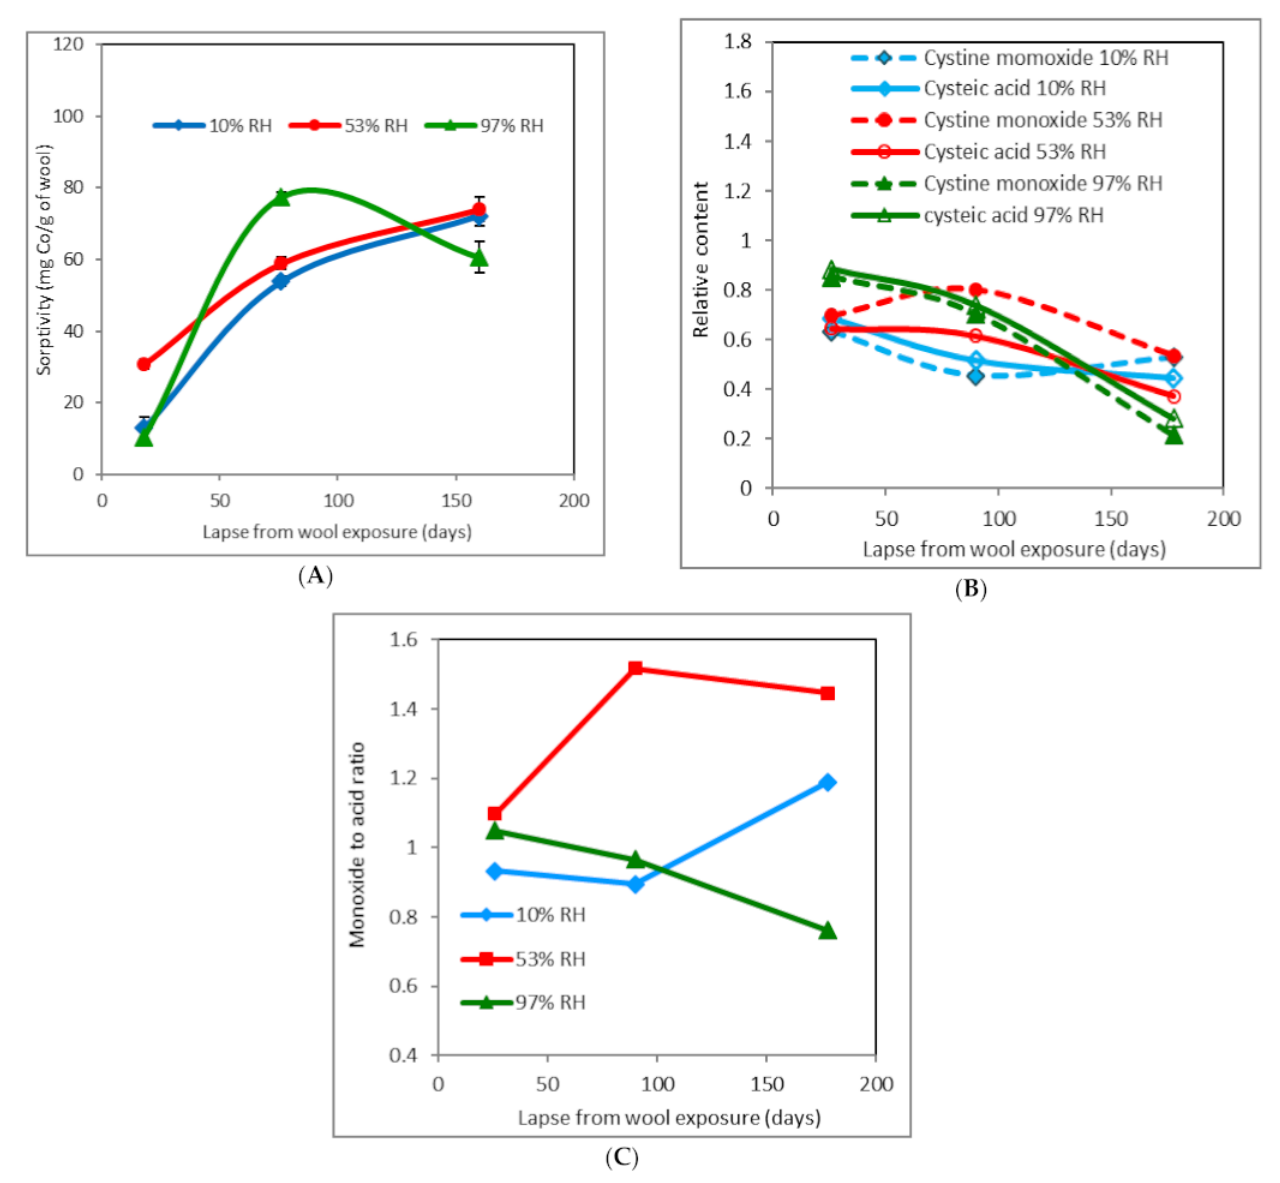
Figure 3. Time development of sorptivity ( A ), relative content of cysteic acid and cystine monoxide ( B ), and cystine monoxide to cysteic acid ratio ( C ) for wool pre-conditioned at different RH and dosed 109 kGy. Measurements were performed after subsequent storage under laboratory